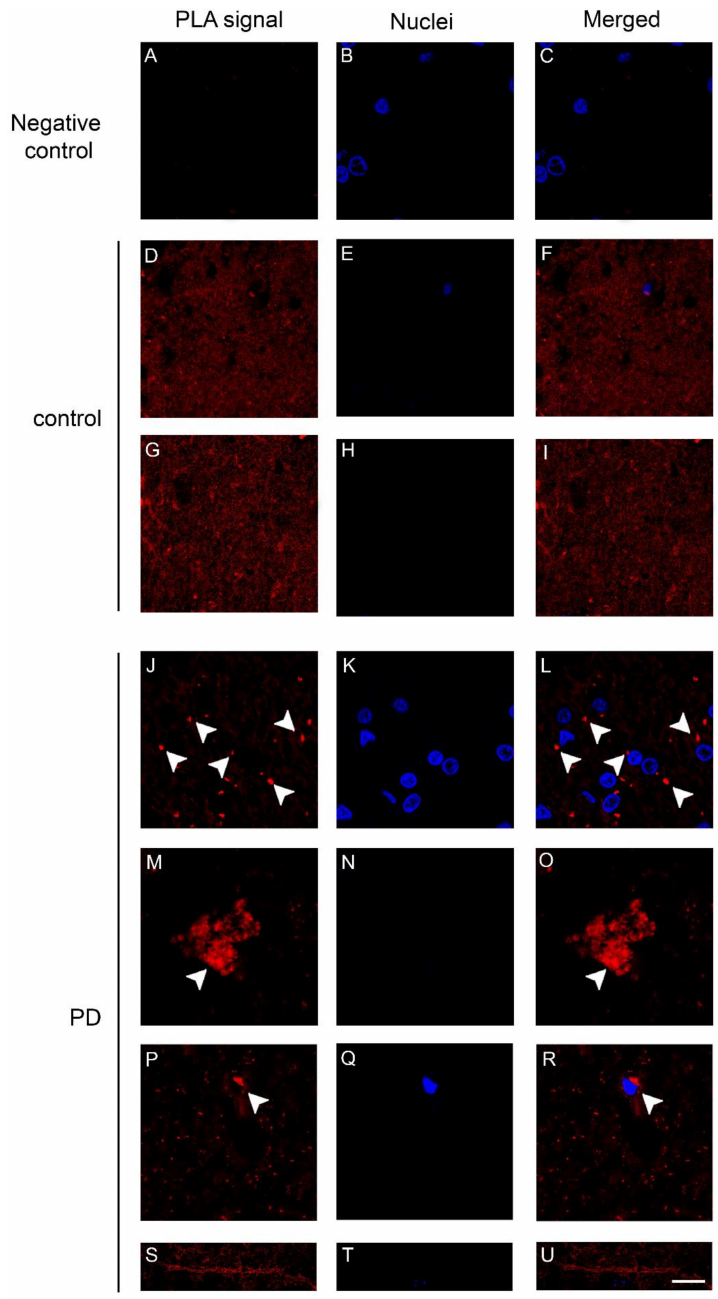
Figure 4. Dopamine transporter (DAT)/ α -synuclein in situ PLA performed on the caudate putamen of PD patients and control subjects. ( A – C ) Panels showing the negative control, performed by omitting the DAT antibody, of the in situ PLA assayed on the caudate putamen of a control subject. The absence of the PLA-positive signal is indicative of the specificity of the assay; ( D – U ) Representative images showing DAT/ α -synuclein in situ PLA performed on the caudate putamen of PD patients ( J – U ) and age-matched-controls (control, D – I ). The presence of a PLA positivity as a red fluorescent signal is indicative of the interaction between the two proteins. Please note the marked redistribution of the PLA-positivity in the caudate putamen of PD samples ( L , O , R ) when compared to the control subjects ( F , I ). In particular, in the PD brains, the PLA signal was particularly abundant within big ( O , arrowheads) and small ( L , R , arrowheads) clumps or neuritic-like structures ( U ). Scale bar: 20 µ